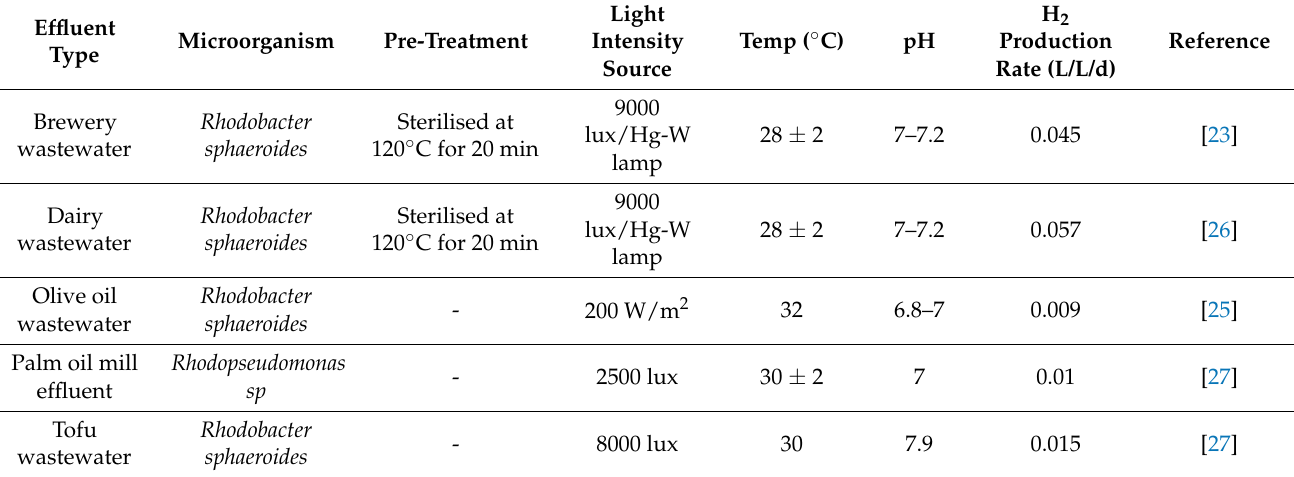
Table 2. Batch photo fermentative hydrogen